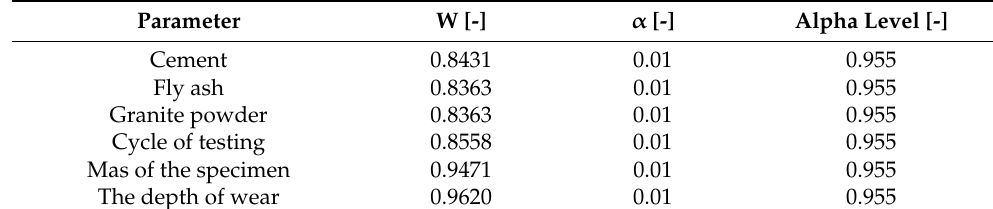
Table 5. Results of the Shapiro–Wilk test.